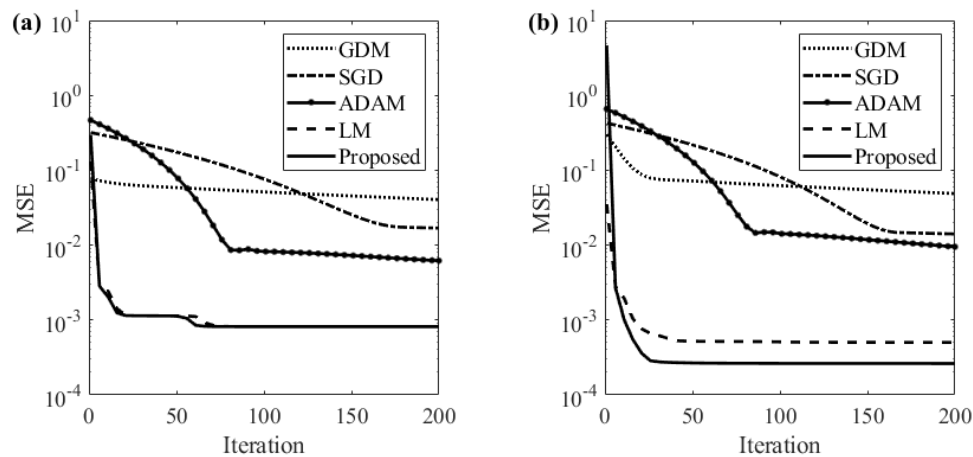
Figure 3. Process data and performance: ( a ) process output and model output obtained from neural network with 7 hidden nodes, ( b ) process input, and ( c ) absolute error between measured and predicted values.